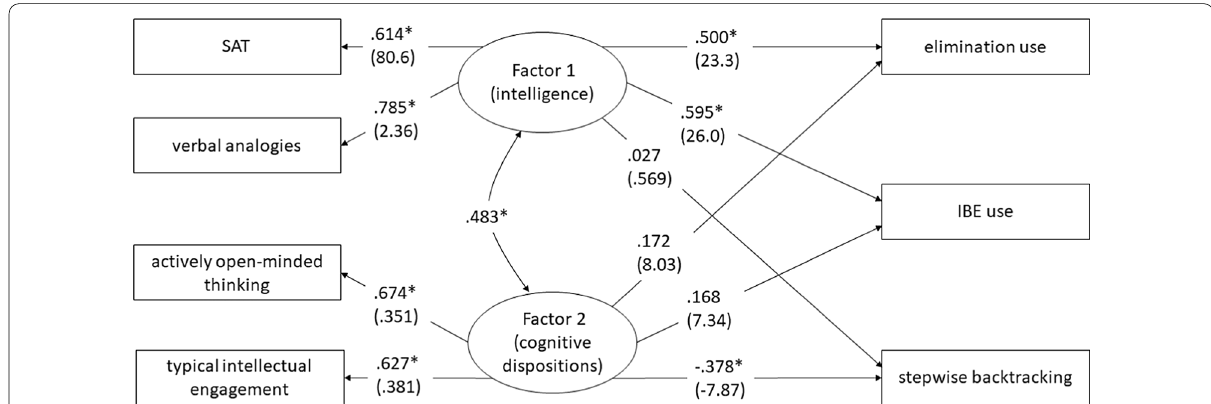
Fig. 4 Structural Equation Model of the effect of intelligence and thinking dispositions on causal inferences in Study 2. Covariances among the three dependent variable error terms are omitted for clarity. Standardized solution (unstandardized coefficients in parentheses), N